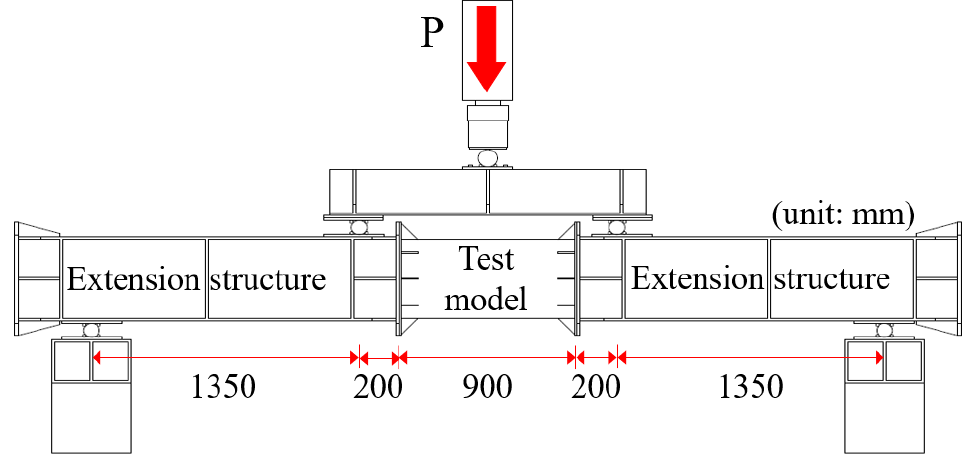
Figure 10. Overall dimensions of the four-point bending-test jig.